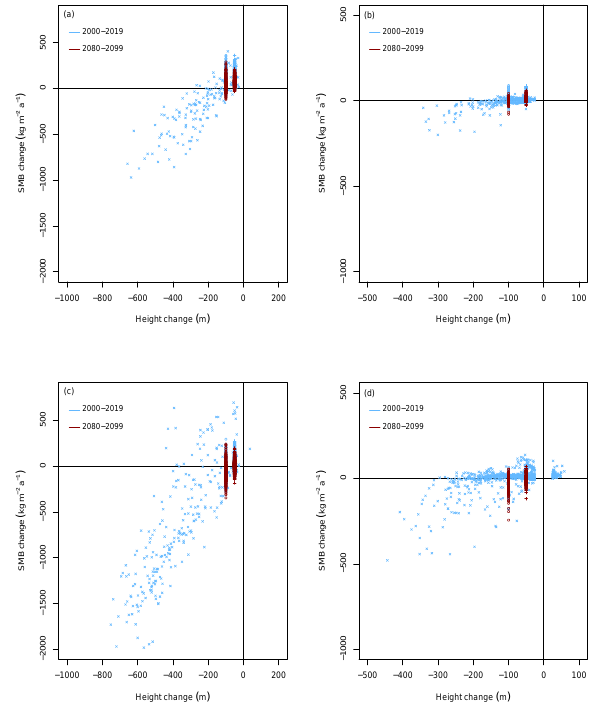
Fig. 5. Scatter plots of SMB change ∆S versus height change ∆h for grid cells north (top row) and south (bottom) of 77 ◦ N, divided into grid cells with SMB in both the control and perturbed experiments less than zero (left column) and greater than or equal to zero (right). Data with height change | ∆ h | < 25m are excluded.